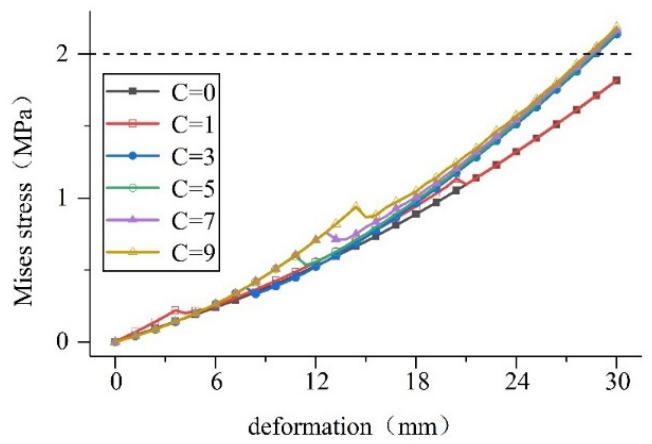
Figure 24. Settlement deformation stress on the waterstop under different bonding force conditions.